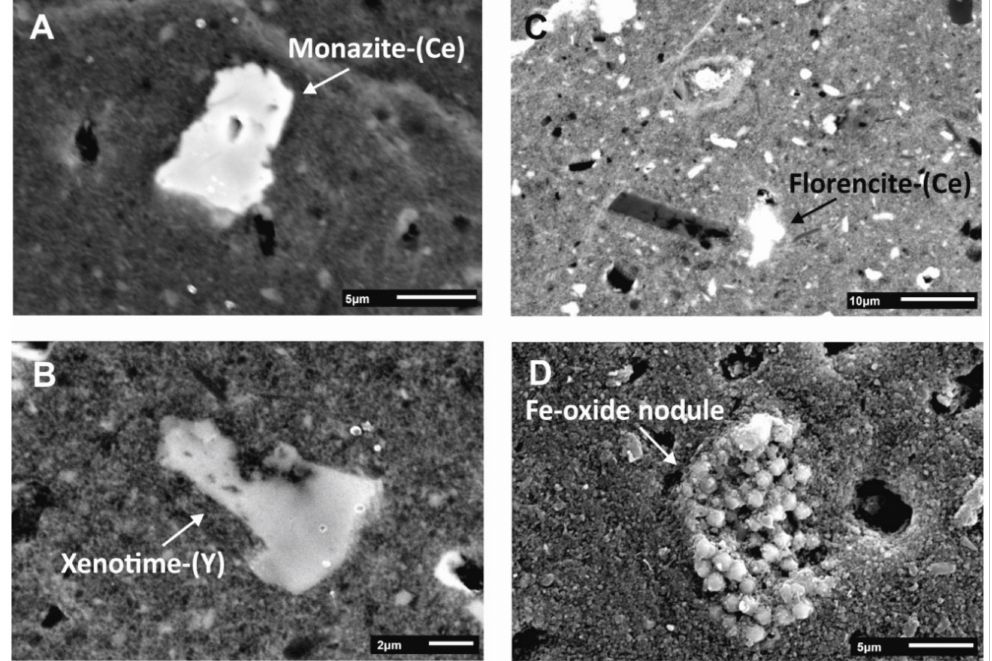
Figure 10. SEM images showing occurrence of REE minerals in the bauxite samples of the Toši´ci-Duji´ci deposit: ( A )—monazite-(Ce) spotted in TOS-3; ( B ): xenotime-(Y) observed in TOS-3; ( C )–florencite- (Ce) occurrence in TOS-3; ( D )—Fe-oxide nodule in TOS-2, a potential scavenger of